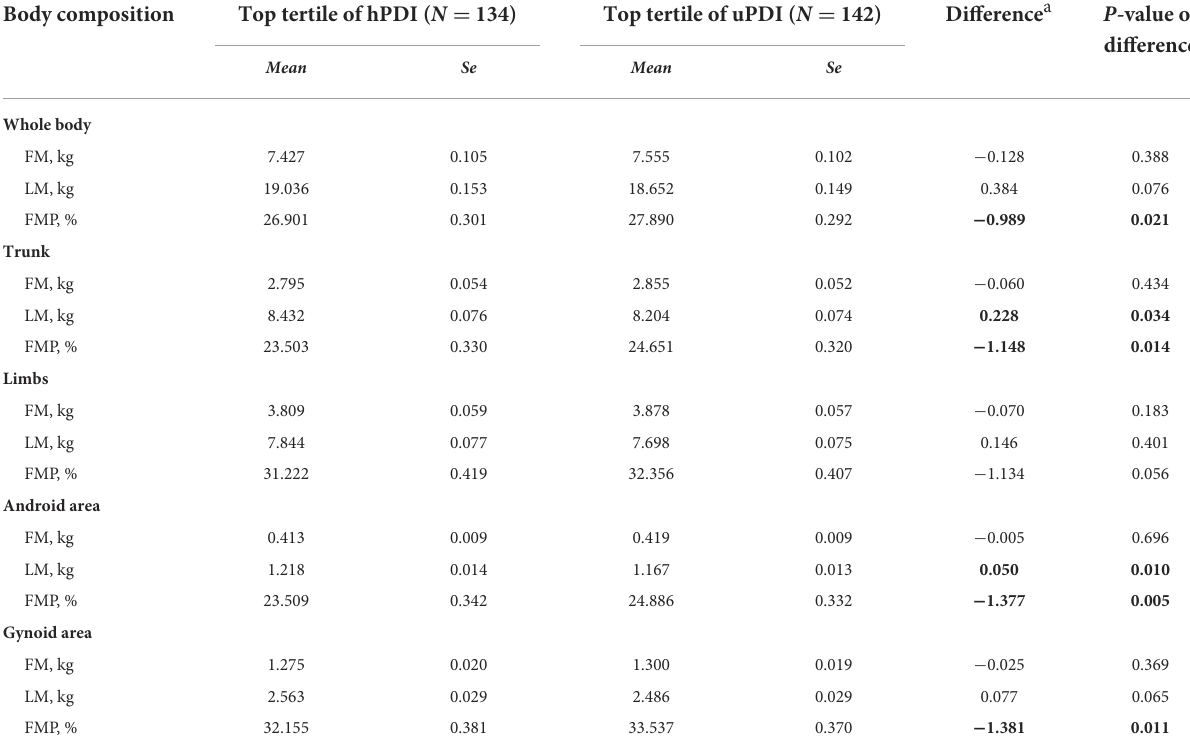
TABLE 4 Comparison of body composition between top tertile groups of hPDI and uPDI scores. Body composition